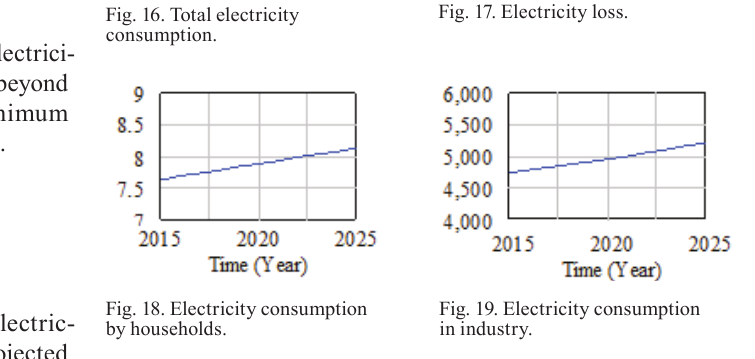
Fig. 19. Electricity consumption in industry.